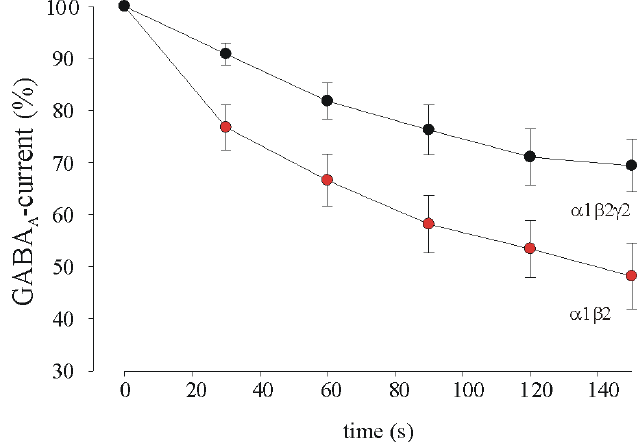
Figure 2. GABA current rundown in HEK cells transfected with GABA A Rs cDNAs. Time course of averaged responses (±SEM; p < 0.05, Mann–Whitney rank sum test) obtained in HEK cells expressing either α 1 β 2 γ 2 ( n = 11, ● ) or α 1 β 2 ( n = 13, ● ) GABA A Rs. In each cell, peak amplitude of subsequent responses was expressed as a percentage of the first response of the rundown protocol.